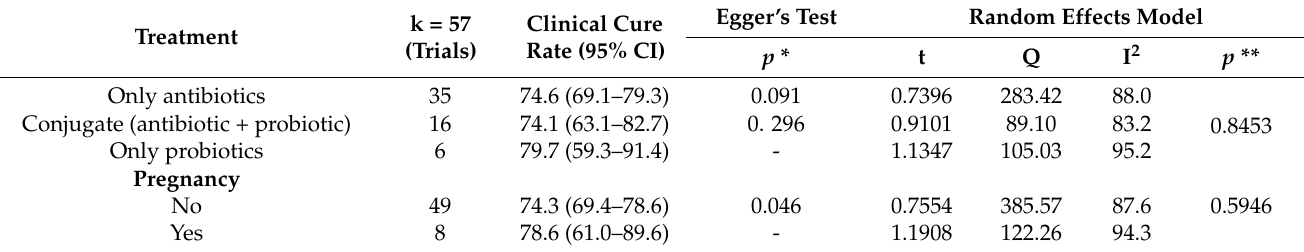
Table 2. Pooled CCR of treatments for bacterial vaginosis among pregnant and non-pregnant women. k = 57 Random Effects Treatment